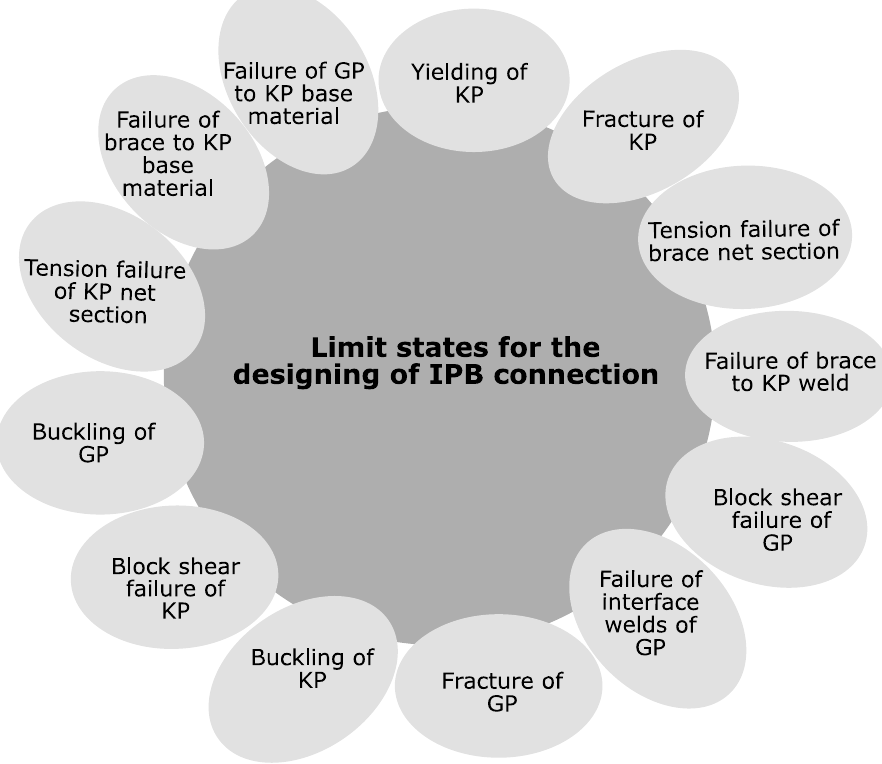
Figure 2. Various limit state criteria for the IPB braced frame system.